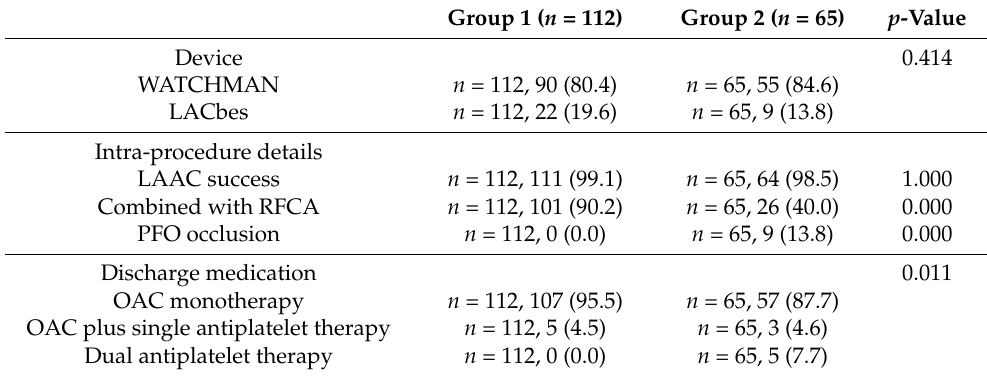
Table 2. Procedure